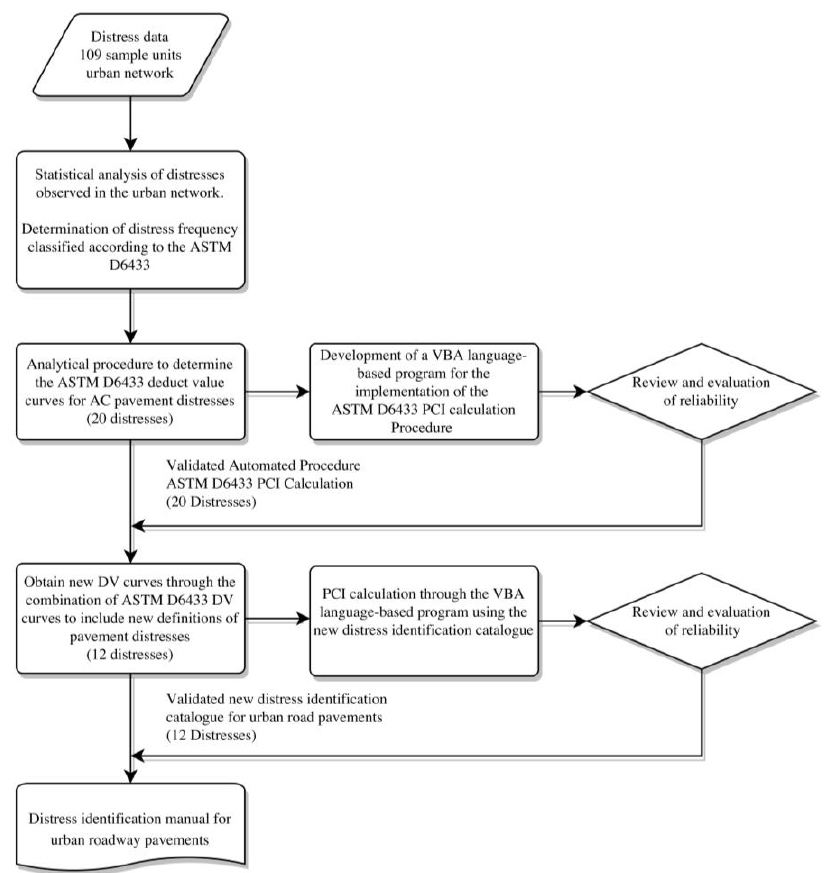
Figure 1. Framework of the specified procedure for distress identification and assessment for urban road surfaces based on PCI, Pavement Condition Index.